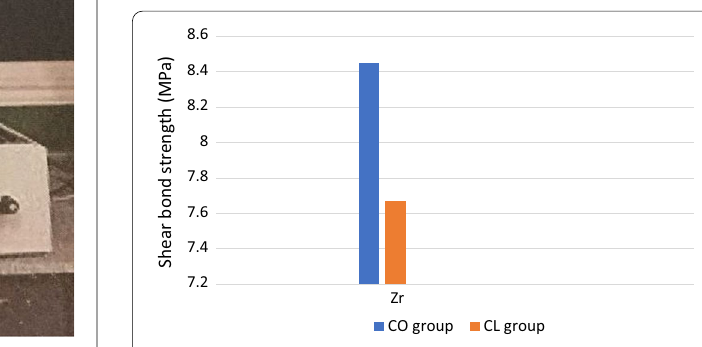
Fig. 5 Thermocycler mechatronics Germany